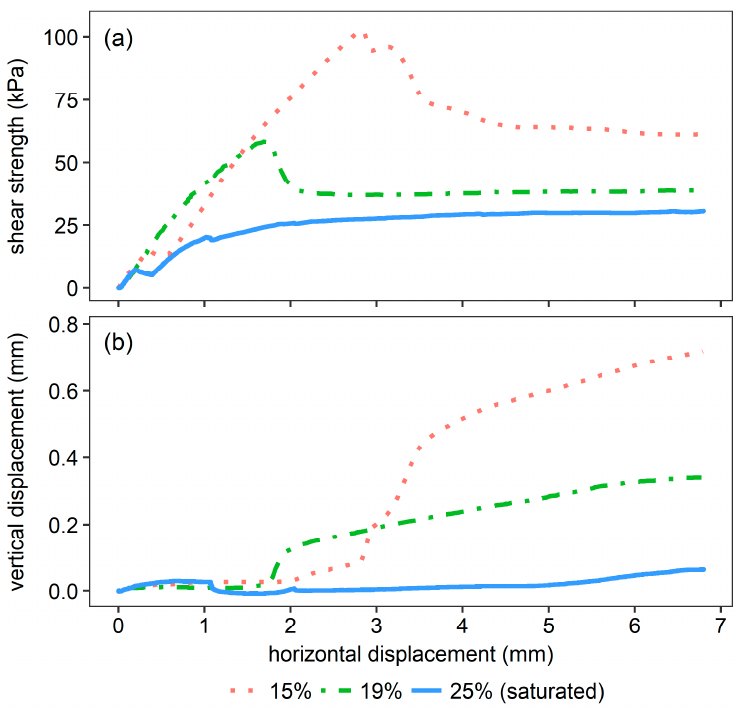
Figure 6. Results of three direct shear tests performed on partially and completely saturated samples applying a normal stress of 21 kPa. ( a ) Shear strength versus horizontal displacement; ( b ) Vertical displacement versus horizontal displacement.